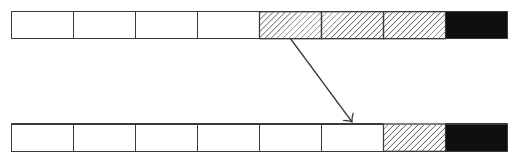
Figure 7: Schematic of passengers changing a